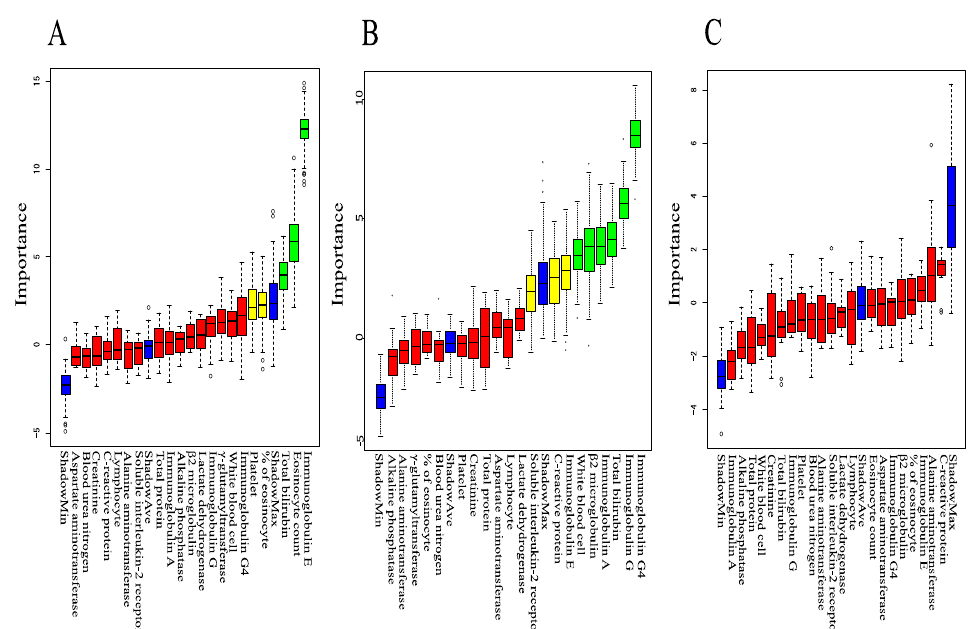
Figure 3. Machine learning analysis using random forest by Boruta multivariate analysis for the prediction of clinical features. Green box denotes a feature confirmed to be important; yellow box denotes a tentative attribute, red box denotes unimportant, and blue box denotes the shadow. ( A ). IgE, Eo count, and T-Bil (three green boxes) are more important for the prediction of extraocular muscle enlargement than other peripheral blood findings. ( B ). WBC, T-Bil, serum IgG, serum IgA, β 2-MG, and serum IgG4 (six green boxes) are more important for the prediction of worsened BCVA than other peripheral blood findings. ( C ). All peripheral blood findings are not important for the prediction of lesion above the neck excluding LG and SG. ◦ , * outlier.